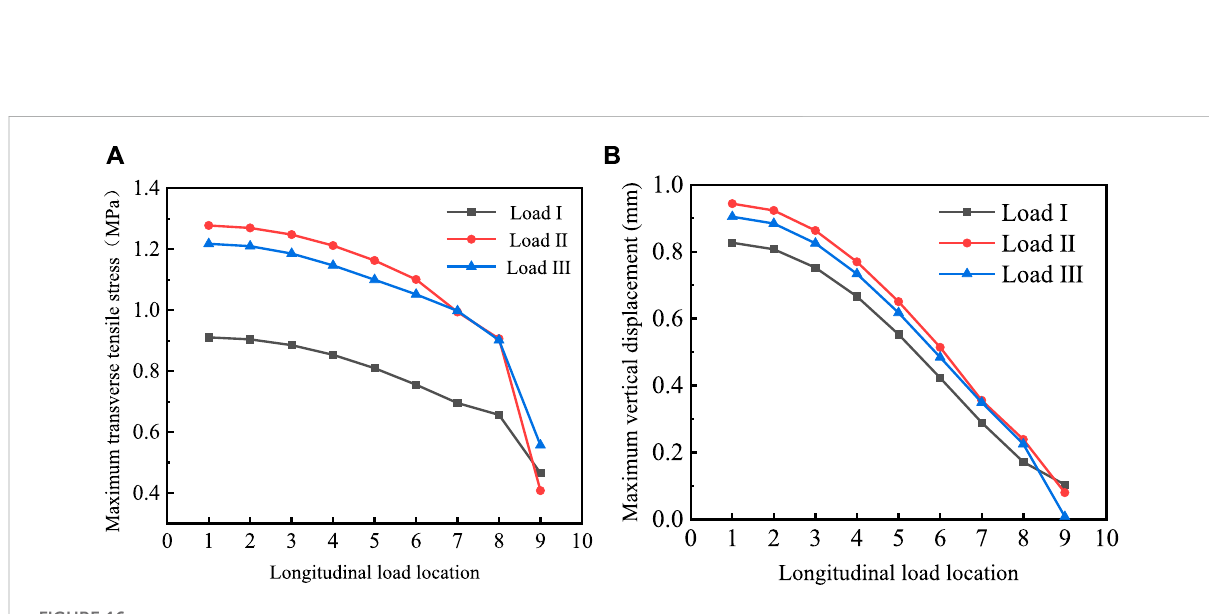
FIGURE 16 Analysis of the most unfavorable load position. (A) Maximum transverse tensile stress of the pavement; (B) Maximum vertical displacement of the